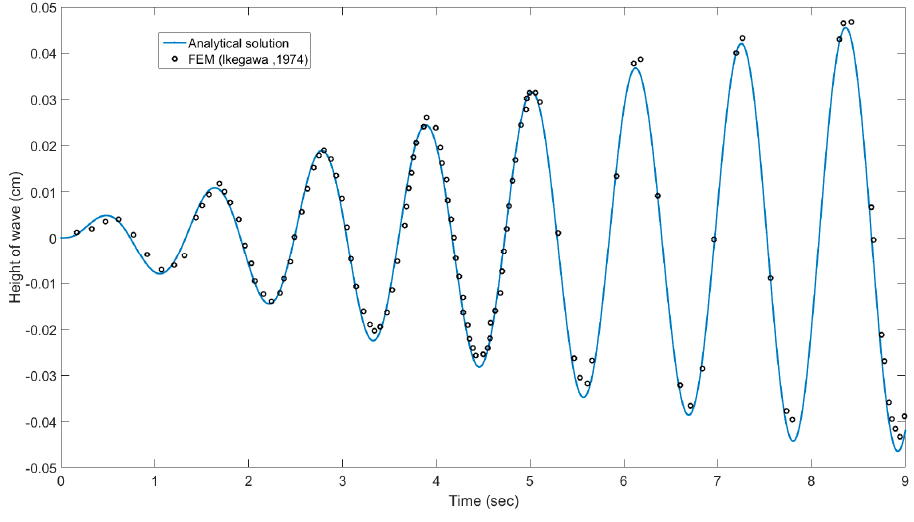
Figure 2. Time history of η ( x = + L , t ).